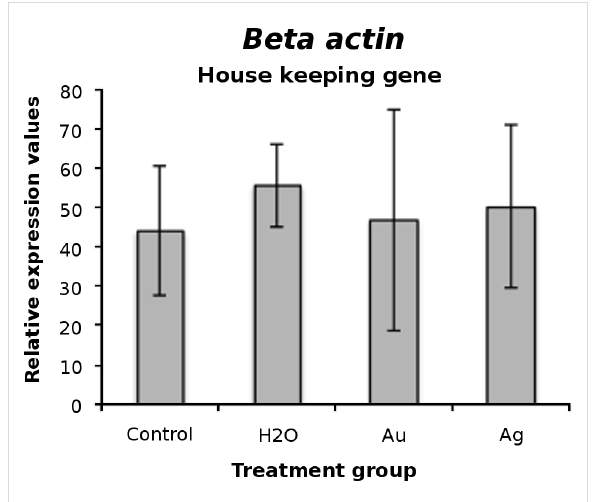
Figure 5: Beta actin expression after normalization with globin. Values are mean ±